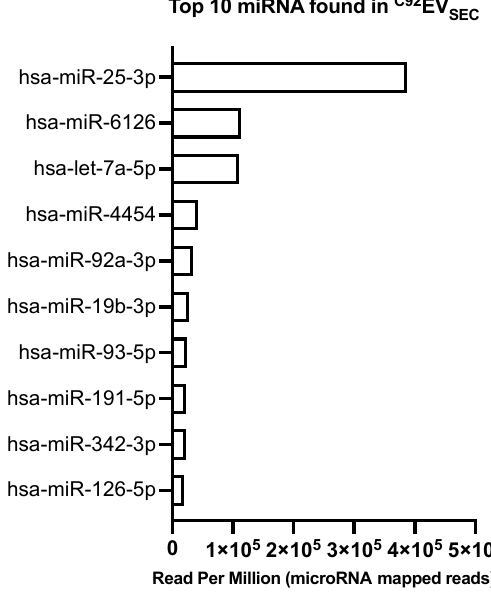
Figure 6. Top 10 miRNA found in C92 EV SEC .